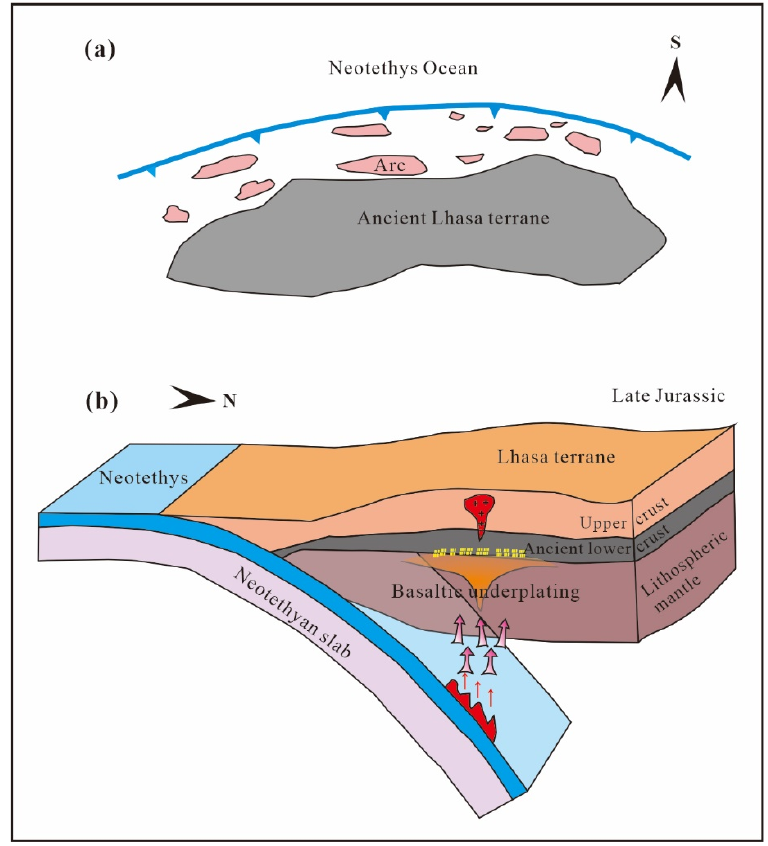
Figure 11. ( a ) Cartoon model of multiple terranes and island arcs in Late Jurassic, Lhasa Terrane; ( b ) cartoon showing dynamic model of the Neo–Tethys ocean subduction and formation of Nuocang granodiorites during the Late Jurassic, southern Lhasa terrane.